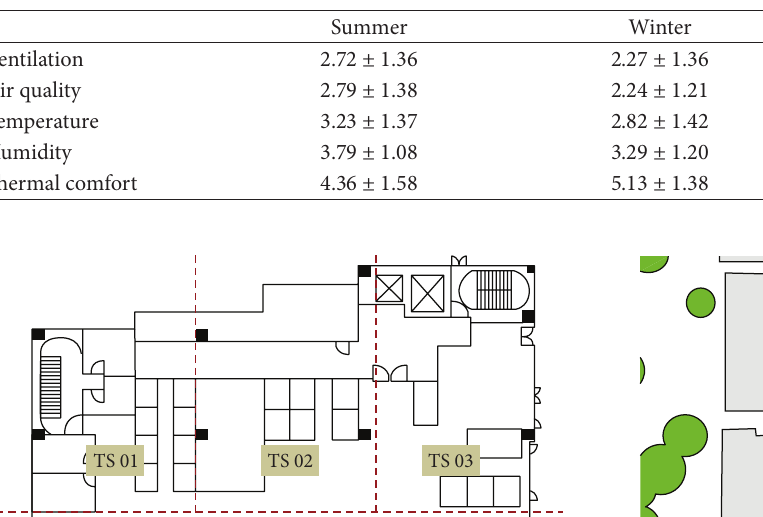
Table 3: Results of the independent samples t -test for the summer and the winter.